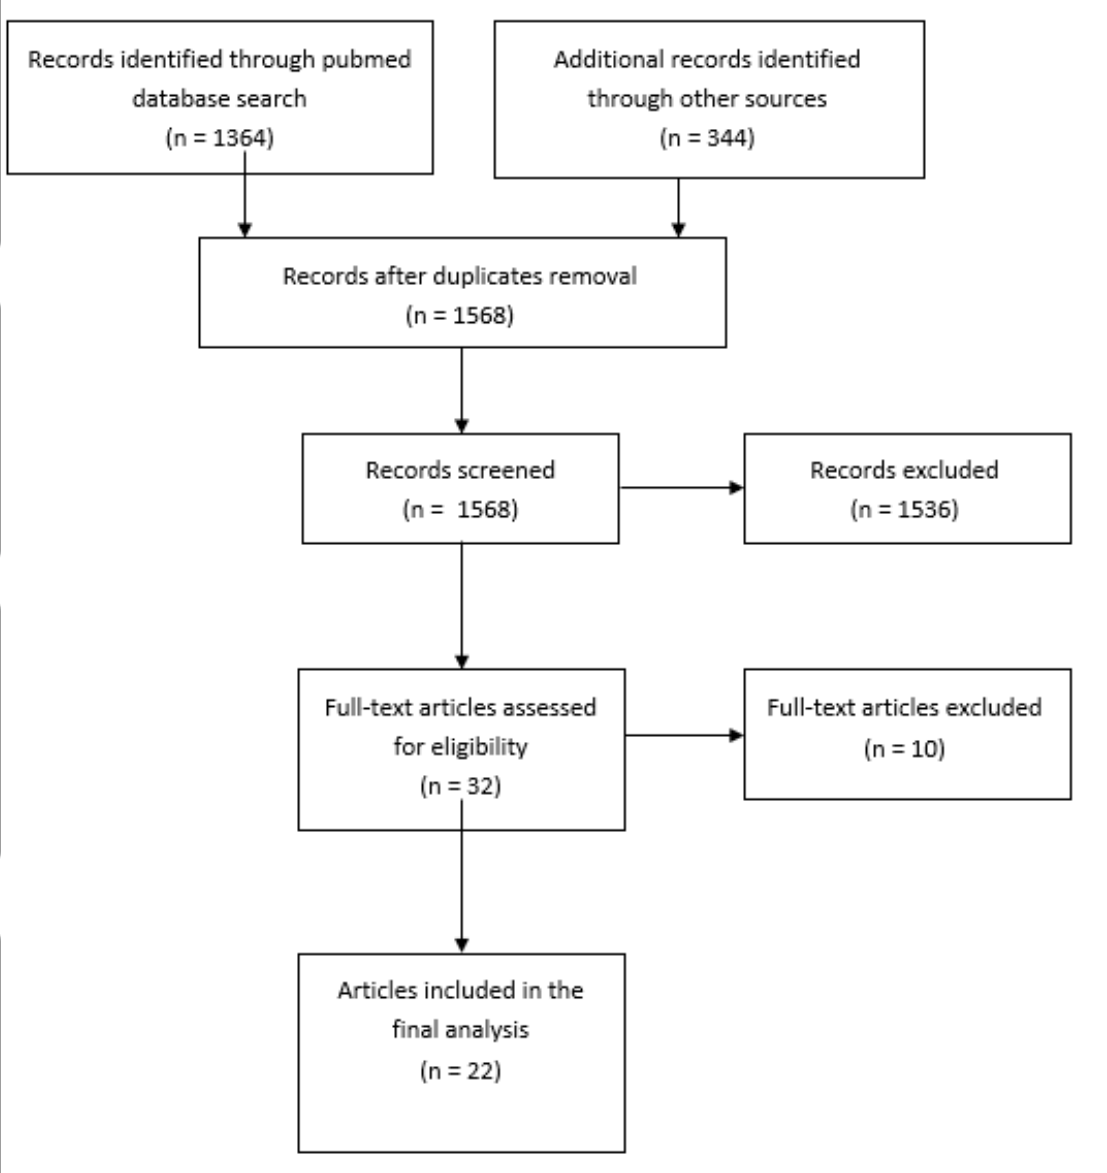
Figure 1. A flow chart of the systematic search process.